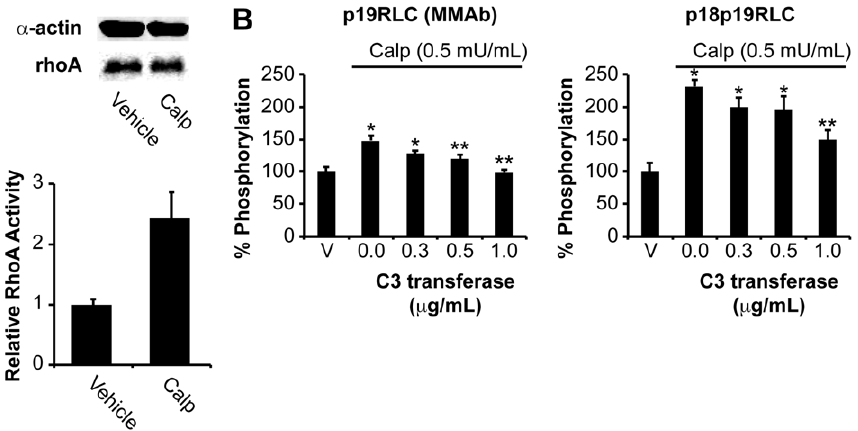
Figure 2. Validation of increased rhoA activity and phosphorylation of RLC by calpeptin. A. Estimation of GTP-bound ‘active’ rhoA in uterine myocytes treated with Calp or vehicle (DMF) for 15 min (n=2). RhoA content was quantified relative to a -actin loading control, and used to correct rhoA activity data. Error bars represent standard deviations. B. Quantification of pRLC and ppRLC in uterine myocytes treated with Calp and with increasing concentrations of a cell-permeable rhoA inhibitor (C3 transferase) by ICW (n=4). * and ** indicate significant differences from vehicle or Calp alone (second histogram), respectively. Calp (calpeptin); rhoA activator (0.5 mU/mL). p , 0.05 in all cases as determined by one-way ANOVA followed by Tukey